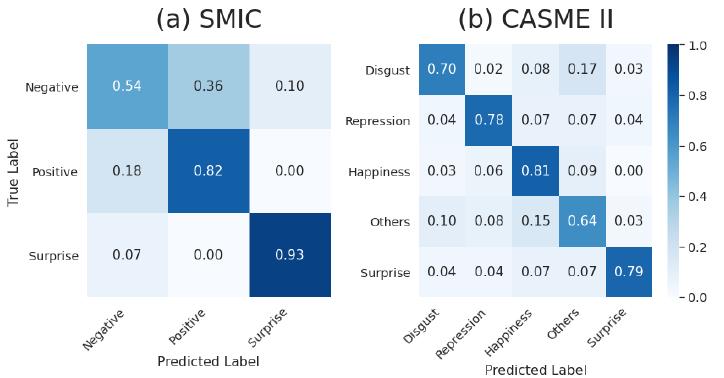
Figure 2. Validation confusion matrices of our method. Each matrix is measured using LOSO. ( a ) is the result of SMIC and ( b ) is the result of CASME